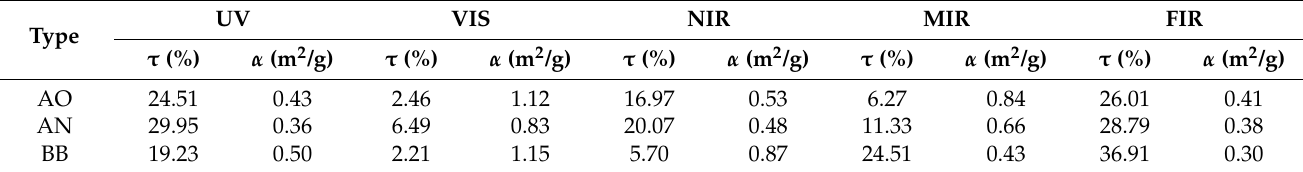
Table 2. The average transmittance values and mass extinction coefficients of the three single- germplasm